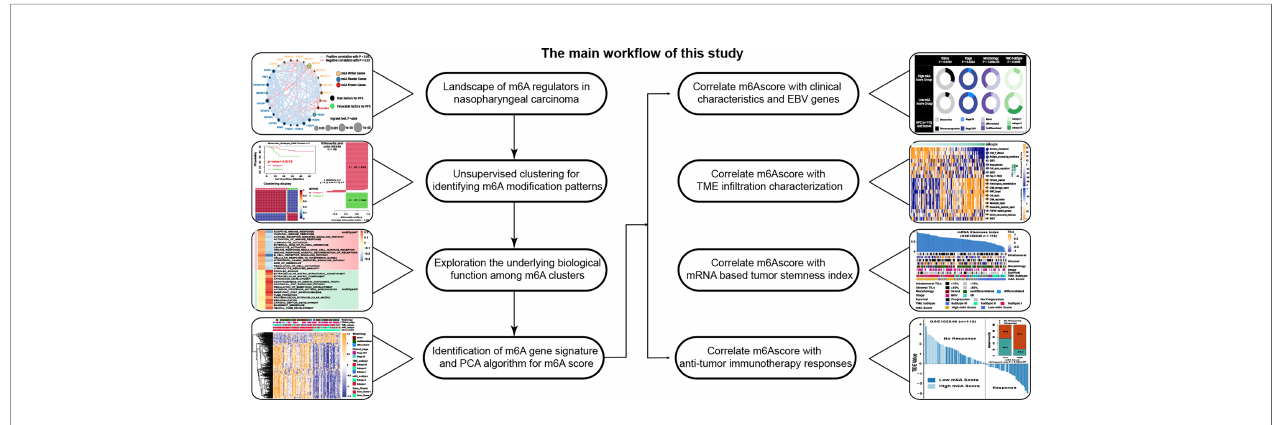
FIGURE 1 | The main work fl ow of this